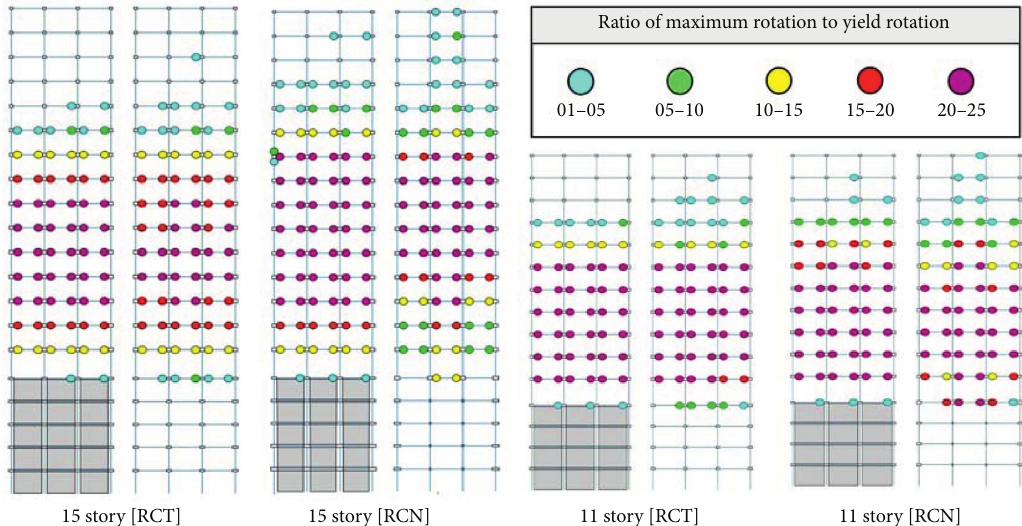
Figure 7: Sideway collapse mechanism of archetype 11 and 15-story buildings with 4 m-long bay lengths under pushover analysis to δ